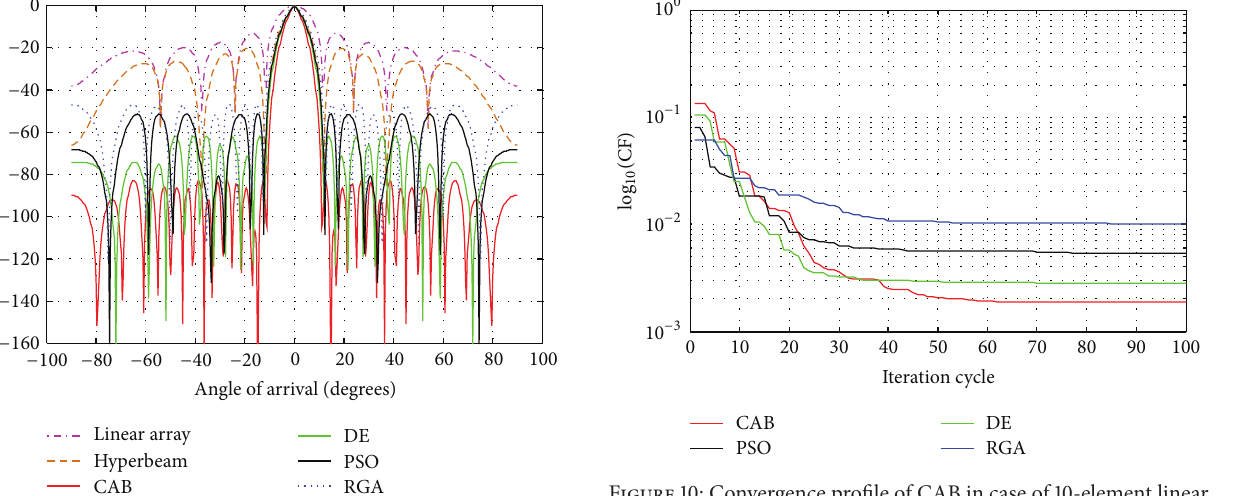
Figure 10: Convergence profile of CAB in case of 10-element linear antenna array at 𝑢 = 0.5